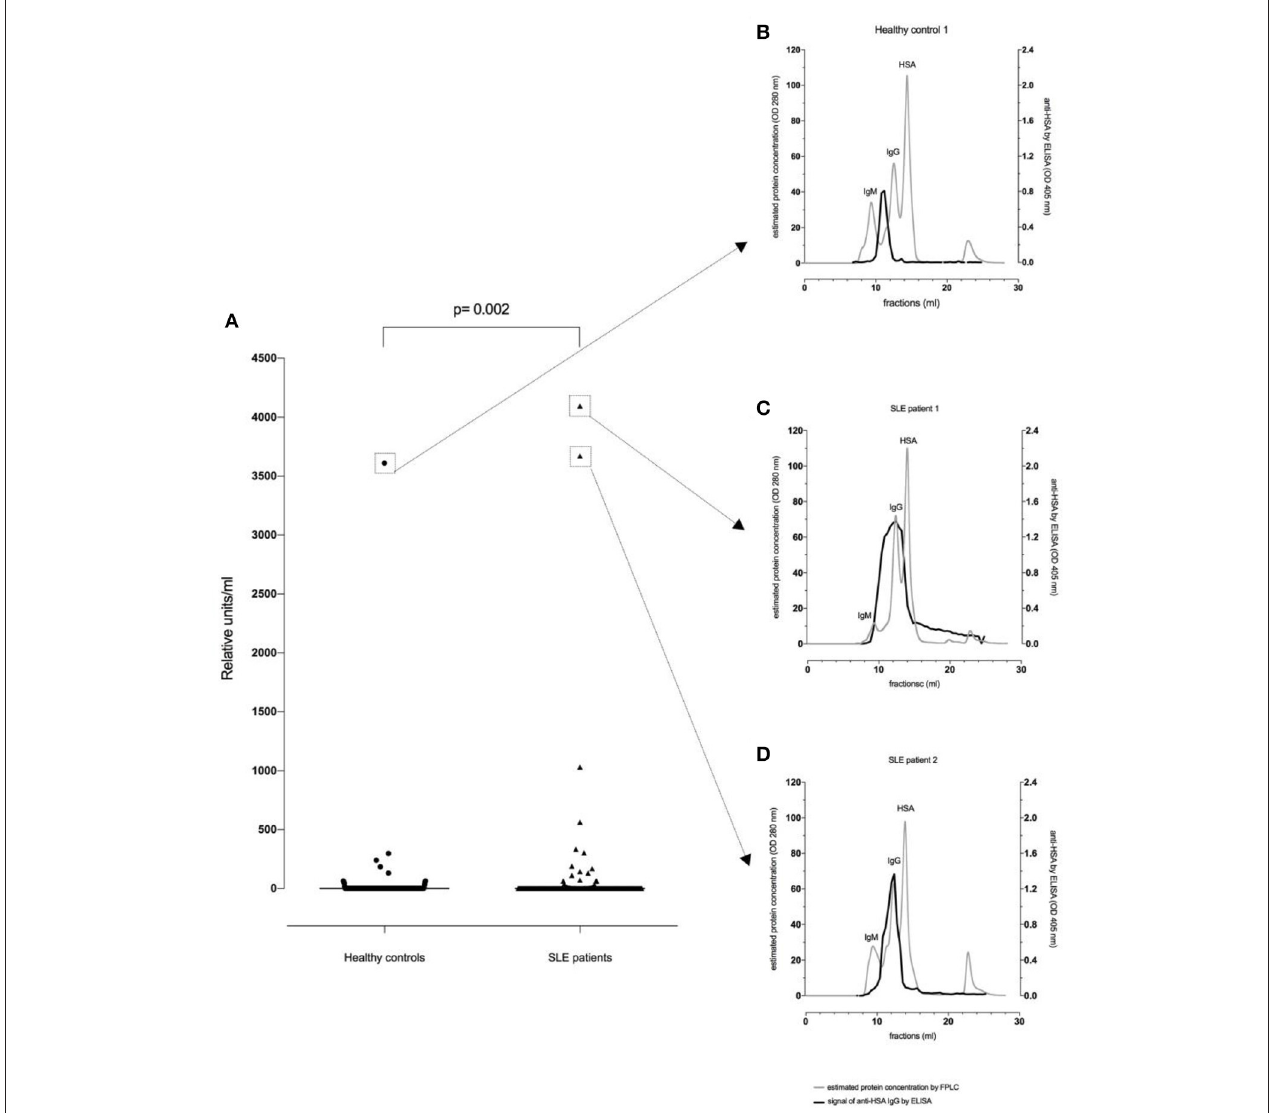
FIGURE 1 | Anti-HSA IgG levels in healthy controls ( n = 188) and SLE patients ( n = 180). There was a significant difference between healthy controls and SLE patients regarding (A) anti-HSA IgG ( p = 0.002). FPLC serum profiles and fractions using FPLC were tested by anti-HSA IgG antibody ELISA for the healthy control with the highest anti-HSA IgG level (B) , the SLE patient with the highest anti-HSA IgG level (C) and for the SLE patient with the second highest anti-HSA IgG level (D) .